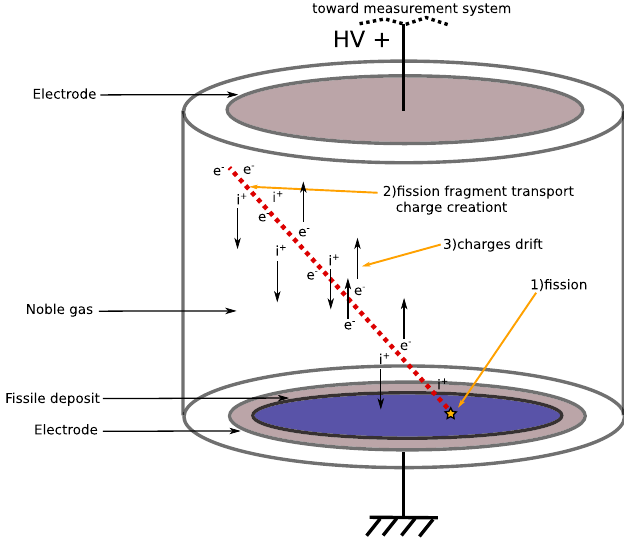
Fig. 2. Schematic fission